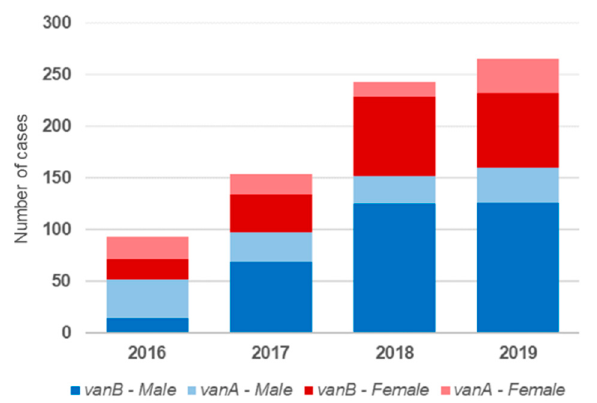
Figure 4. Sex distribution of the analyzed VREBI samples, classified by resistance determinants.